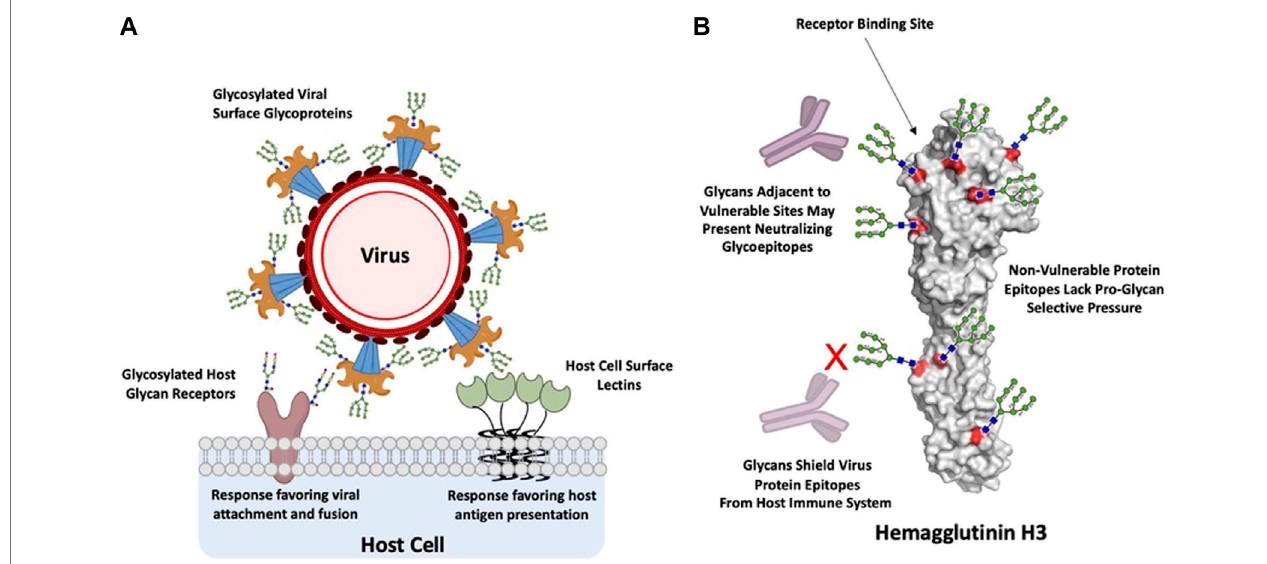
FIGURE 1 | Glycan interactions between host and virus. (A) , glycan interactions between host cells and viruses are predominantly mediated by host or virus glycoproteins andtheir complementaryhostorvirusglycanbindingproteins. Thesebindingevents triggerprocesses thatfavoreither viralattachmentand fusionor host recognition and response. (B) , Hemagglutinin H3 from In fl uenza A Wyoming/3e/2003, depicted with Man9 glycans and theoretical mAbs for illustrative purposes. Glycans shield vulnerable protein epitopes from neutralizing mAbs, such as thereceptor binding site, while non-vulnerable protein epitopes lack selective pressure for glycan shielding. However, these glycans can also present targets as glycoepitopes. Generated in PyMOL from PDB: 6BKN (Wu et al.,